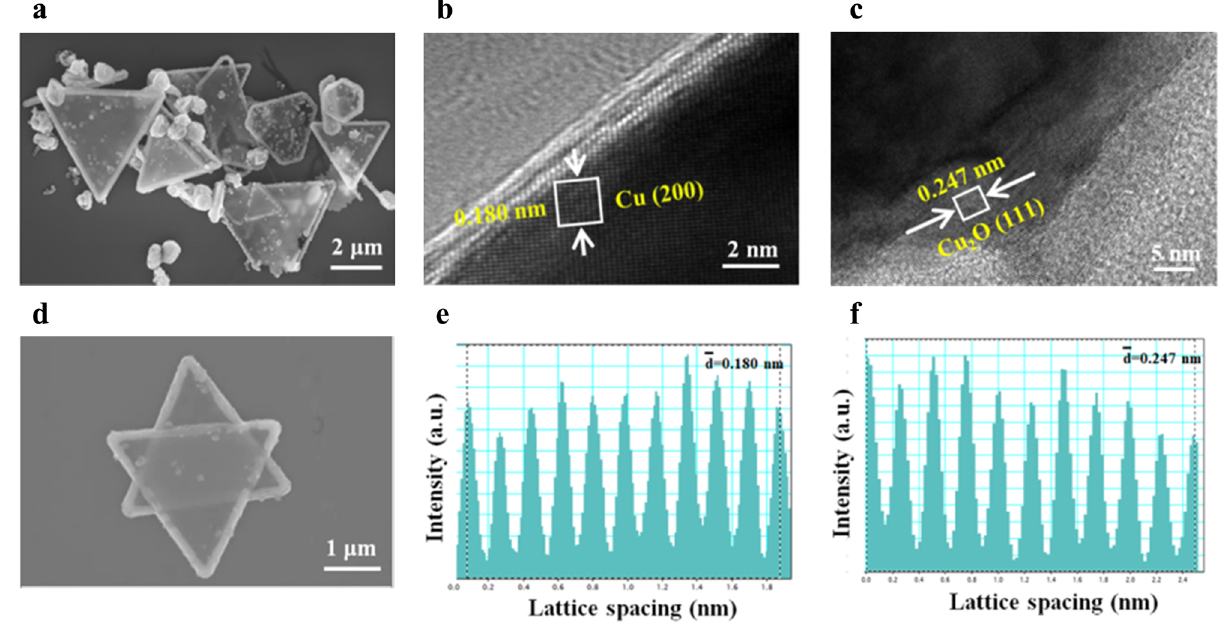
Fig. 2 | SEM and TEM images for Cu/Cu 2 O-A. a , d SEM, b , c TEM and e , f Intensity pro fi les measured from the regions marked by the white squares in images b and c, respectively.